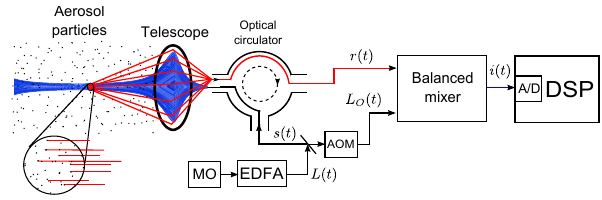
Figure 1. Heterodyne receiver with IF sampling (HCDL). To be able to capture the full return signal power a balanced mixer/detector needs to be employed; for details please see Abari et al. (2014). MO and EDFA represent the master oscillator and erbium-doped fiber amplifier, respectively. Optical circulator iso- lates the transmit, s(t) , and the receive signal, r(t) . L o (t) represents the local oscillator signal, A/D is the analog-to-digital converter, and DSP is the digital signal processor unit.